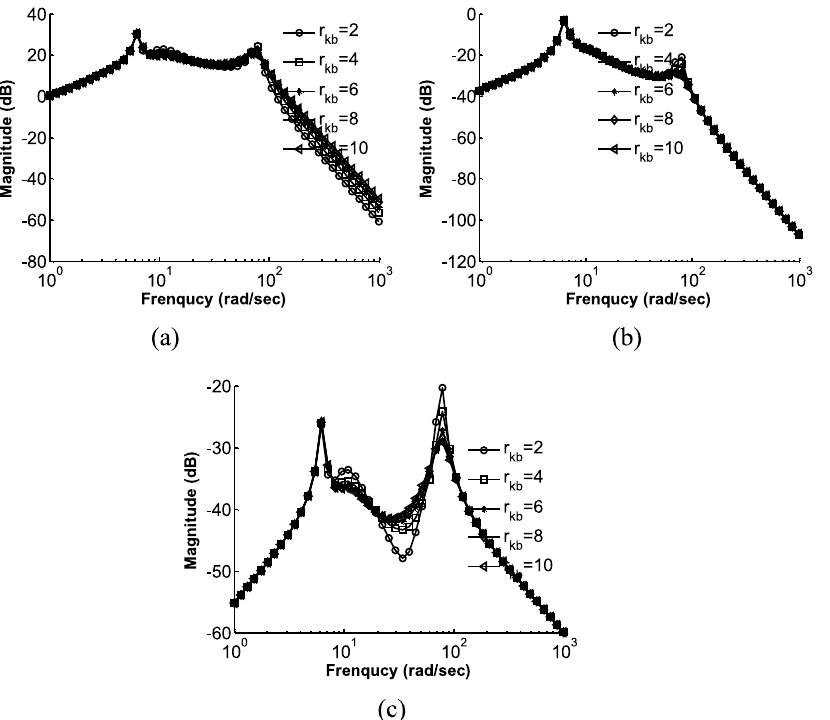
Fig. 14. Frequency response with layout s8: (a): Sprung mass acceleration response; (b): Suspension de fl ection response; (c): Tire de fl ection